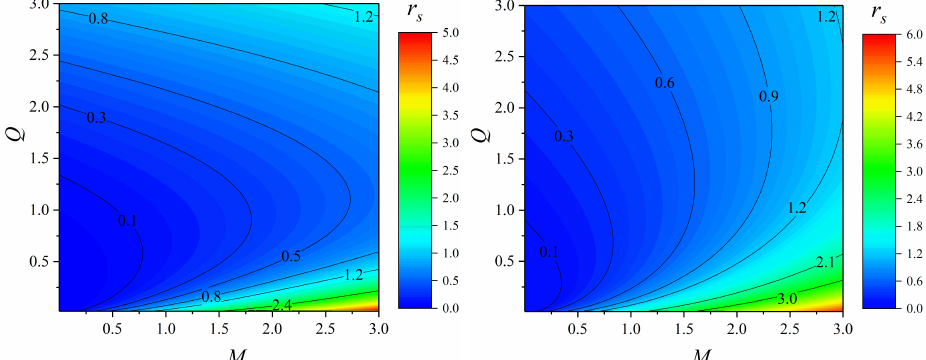
Figure 3. Radii of SS for different M , Q ; n = 6 ( left ), n = 18 ( right ).